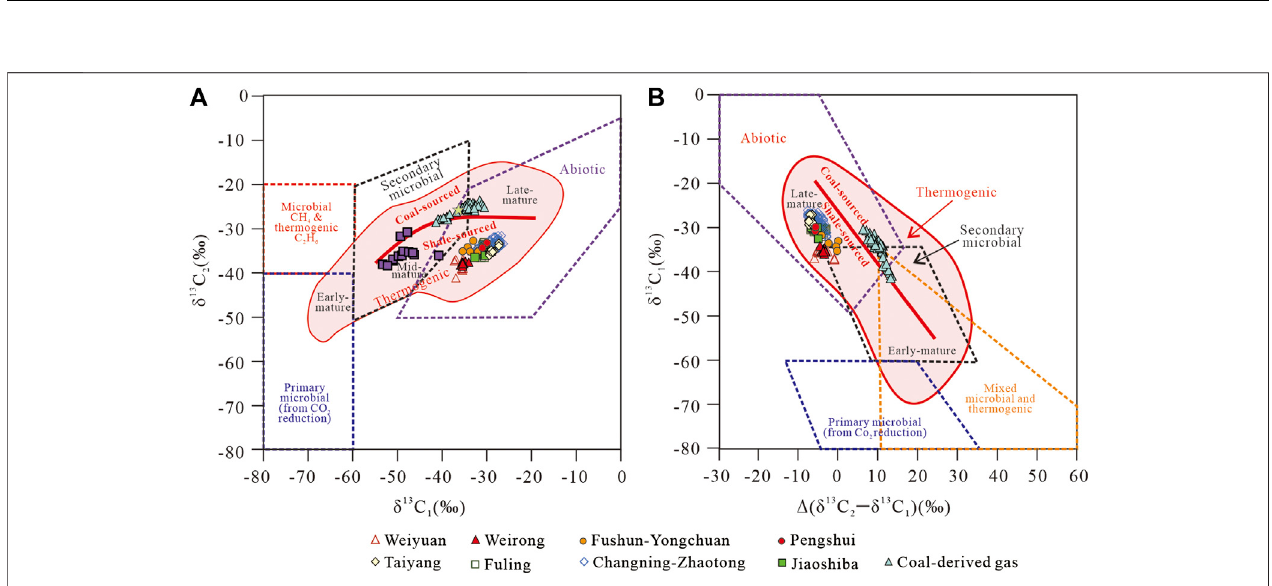
FIGURE6| Plotsof δ 13 C 1 versus δ 13 C 2 (A) and δ 13 C 1 versus Δ ( δ 13 C 2 – δ 13 C 1 ) (B) ofgasesfromtheTaiyang,Jiaoshiba,andWeironggas fi eldsintheSichuanBasin, China. Also shown are shale gases from the published data (see text). Modi fi ed from Milkov (2021).